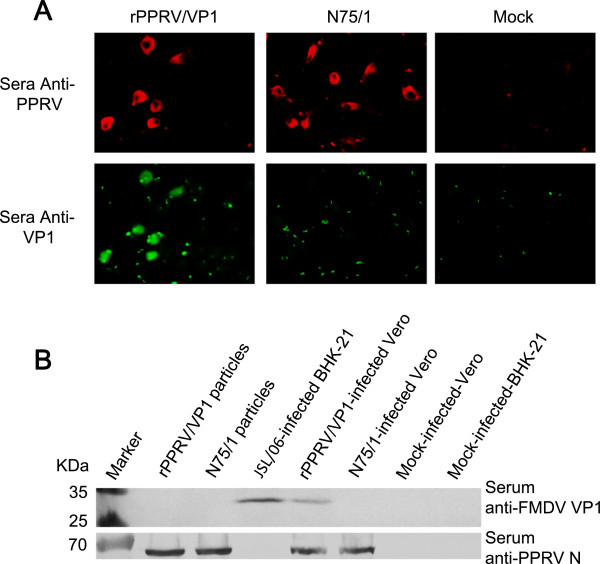
VP1 protein replication and expression of rPPRV/VP1 in Vero cells. (A) Cells infected with rPPRV/VP1, N75/1, or mock-infected were fixed and labeled with anti-N75/1 mouse serum for the presence of PPRV protein (red) or anti-FMDV VP1 (Asia-I type) rabbit serum for the presence of the VP1 protein (green). (B) The N75/1 and rPPRV/VP1 particles were respectively purified by sucrose gradient centrifugation with 60%, 40% and 20% density (140 000 g). Lysates of N75/1- or rPPRV/VP1-infected Vero cells, lysates of FMDV JSL/06-infected Vero cells, N75/1 particles and rPPRV/VP1 particles were respectively probed by SDS-PAGE and western blotting using anti-FMDV VP1 (Asia-I type) rabbit serum and anti-PPRV-N rabbit serum respectively. Mock-infected Vero and BHK-21 cells were used as controls.